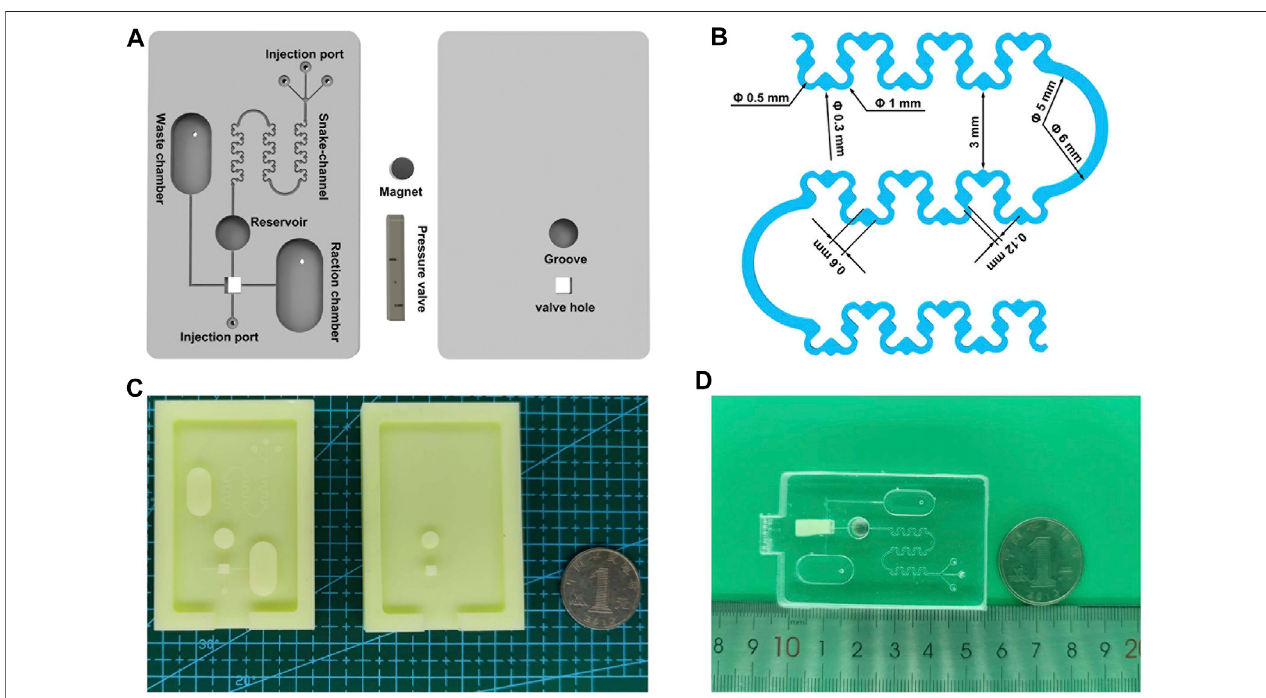
FIGURE2 |(A) Schematic diagram ofSSMC. (B) Optimized size ofsnake-shaped mixingchannel. (C) The molds of micro fl uidic chips. (D) Apicture